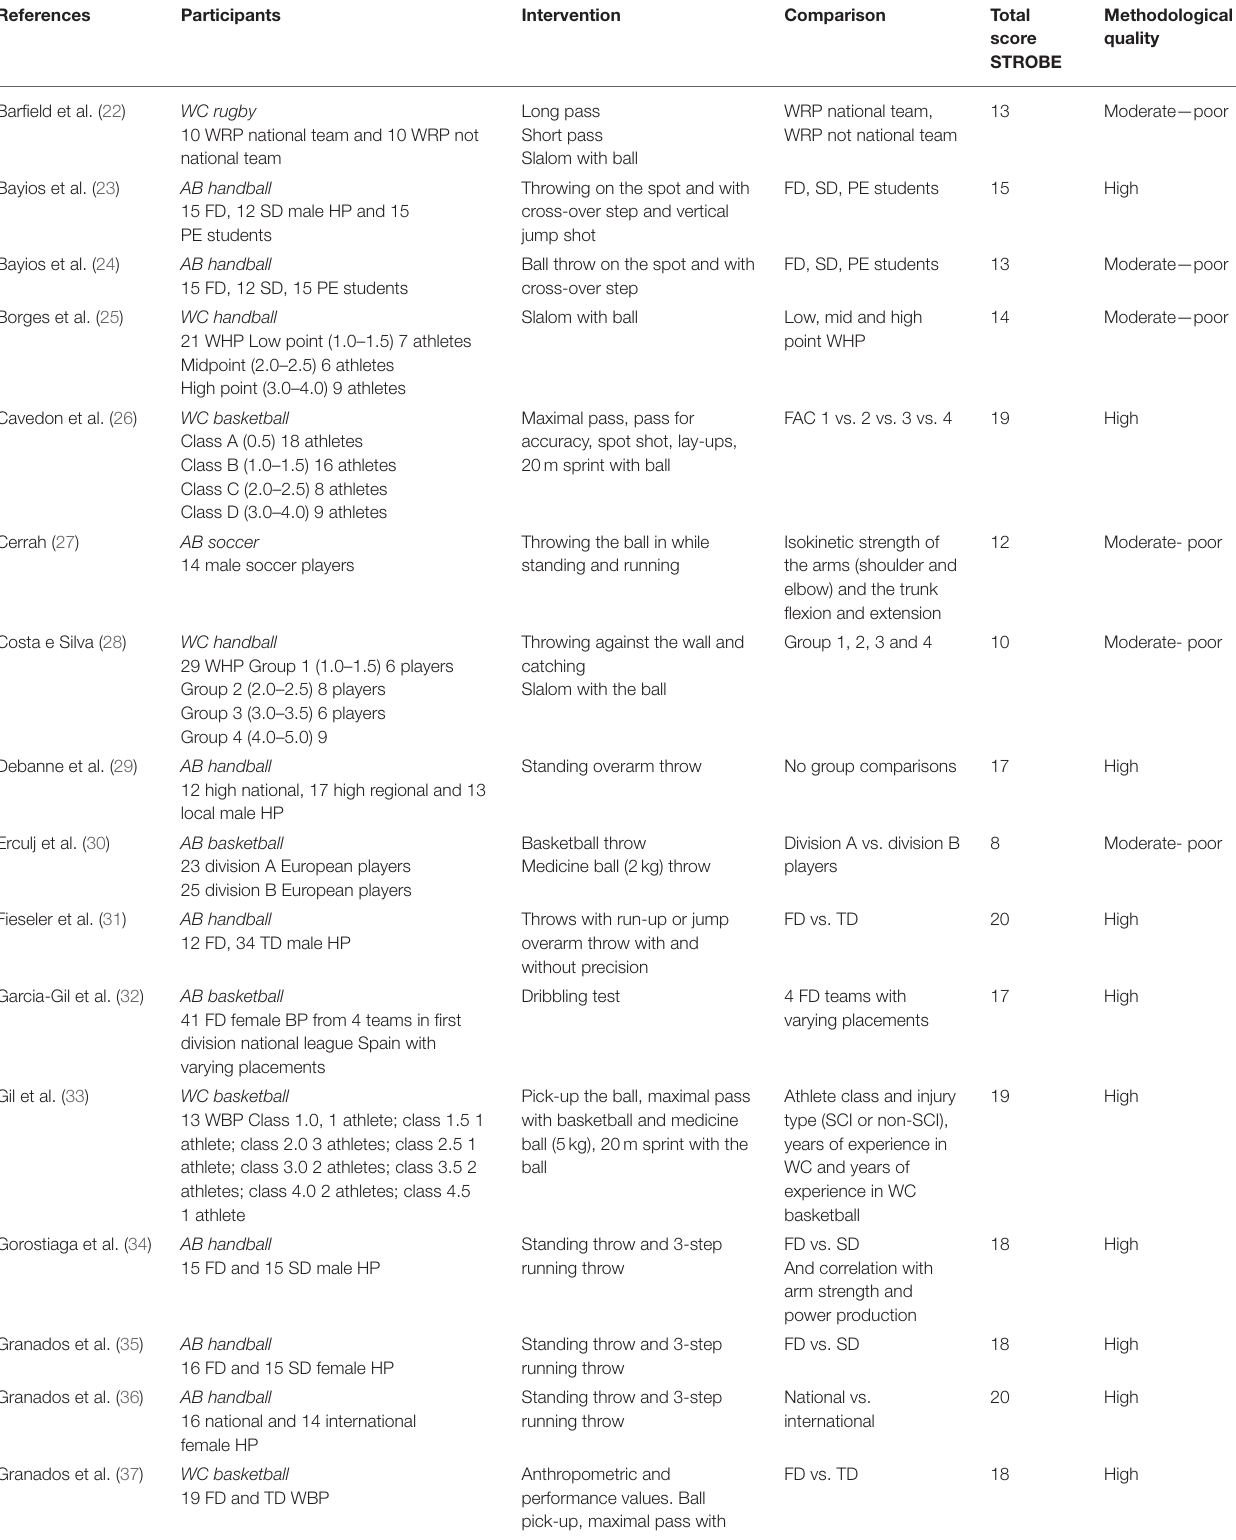
TABLE 1 | Study participants, interventions, comparisons, and STROBE